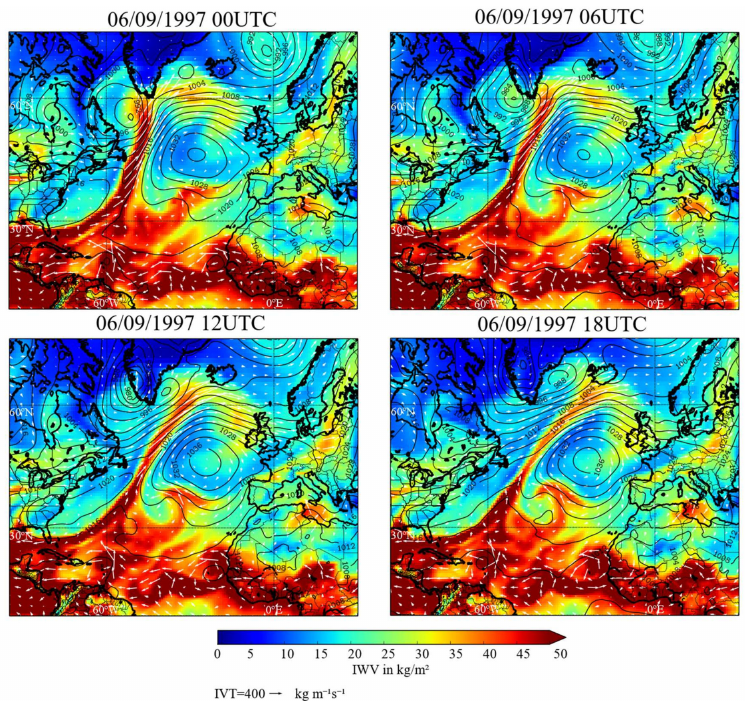
Figure 4. Integrated Water vapour column (IWV) and IVT for the AR event occurred on 6 September 1997. Black isolines represent the Mean Sea Level Pressure in